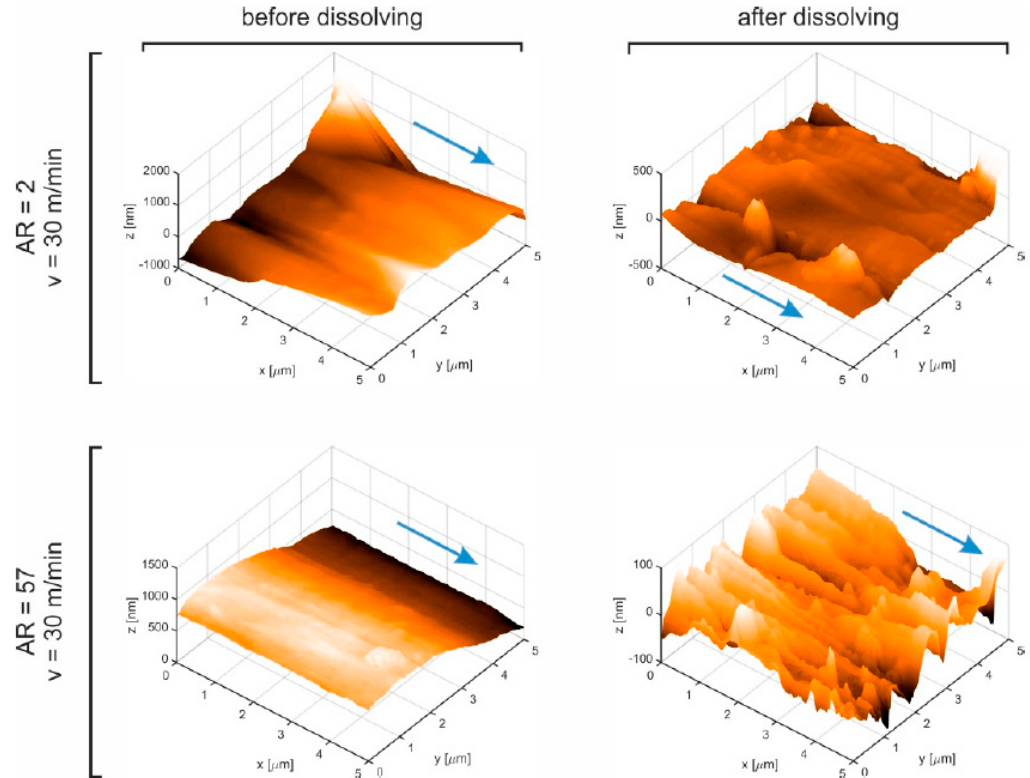
Figure 9. Atom force microscopy images of the surface patterns of PP / PS gradient fibers after hot-drawing, before (left column) and after (right column) dissolving PS. The upper and lower rows show the surfaces of the fibers processed with v = 30 m / min and aspect ratio of capillary AR = 2 and 57, respectively. The weight percent of PS is 20% and the viscosity ratio of PS / PP is 2.45. Arrows indicate the fiber axis [6]. Reused with permission from Pan, D.; Hufenus, R.; Qin, Z.; Chen, L.; Gooneie, A., Macromolecular Materials and Engineering; published by John Wiley and Sons,